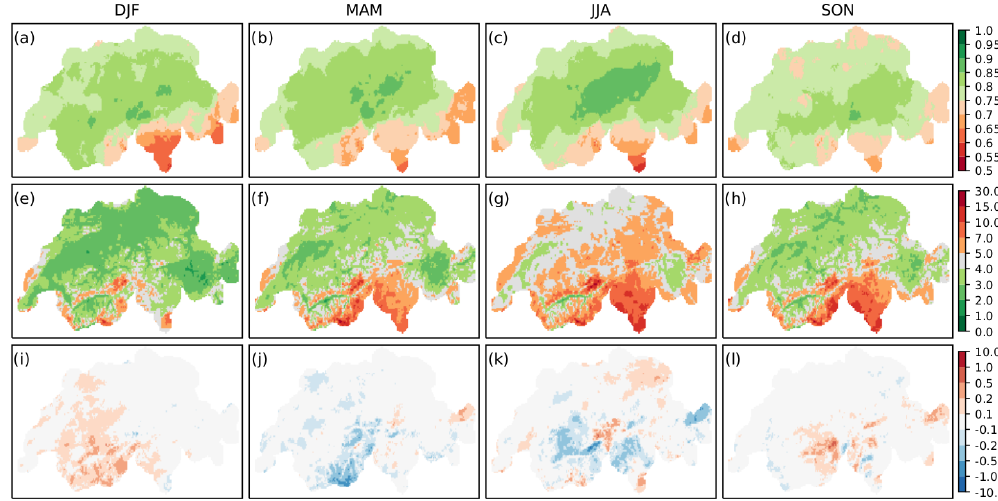
Figure 4. Validation of quantile-mapped precipitation over time by season. Shown are the Spearman correlation (a–d) , RMSE (mm) (e–h) , and bias (mm) (i–l) .